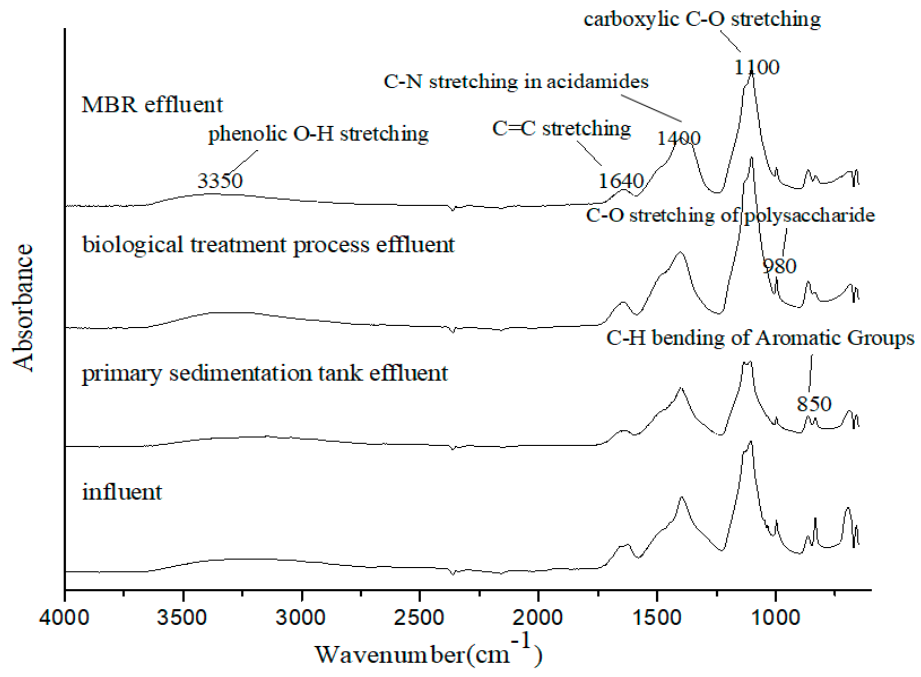
Figure 3. FT–IR spectra of the Figure 3. FT ‒ IR spectra of the WWTP.